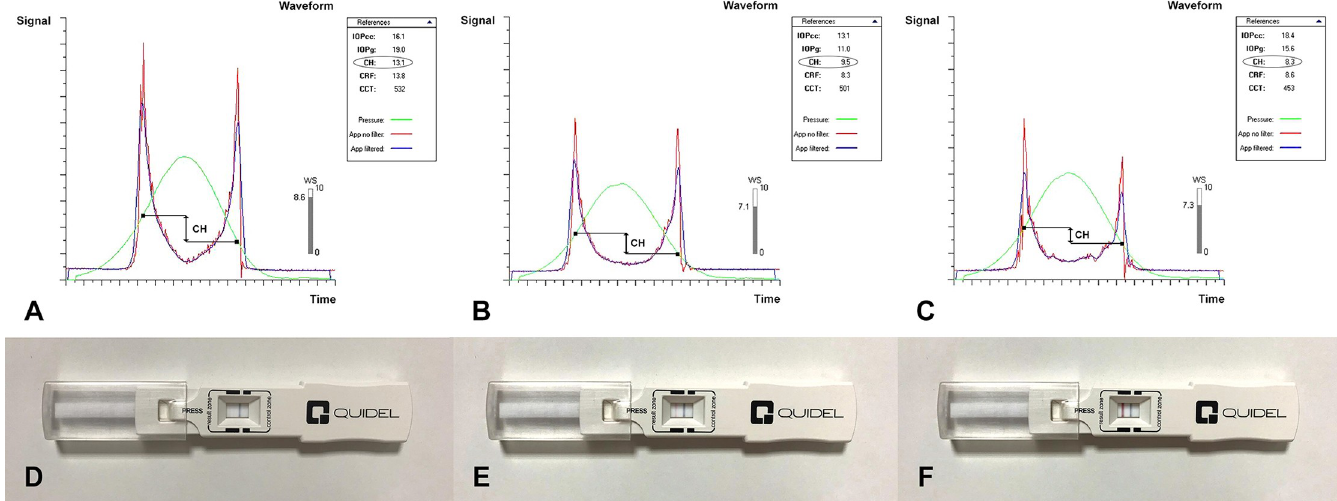
Fig 1. Ocular response analyzer measurement signals and InflammaDry assays of 3 representative subject. A, D healthy control, negative for MMP-9; B, E ocular graft versus-host disease (oGVHD) patient (severity grade I), weak-positive for MMP-9; C, F oGVHD patient (severity grade II), strong-positive for MMP-9.